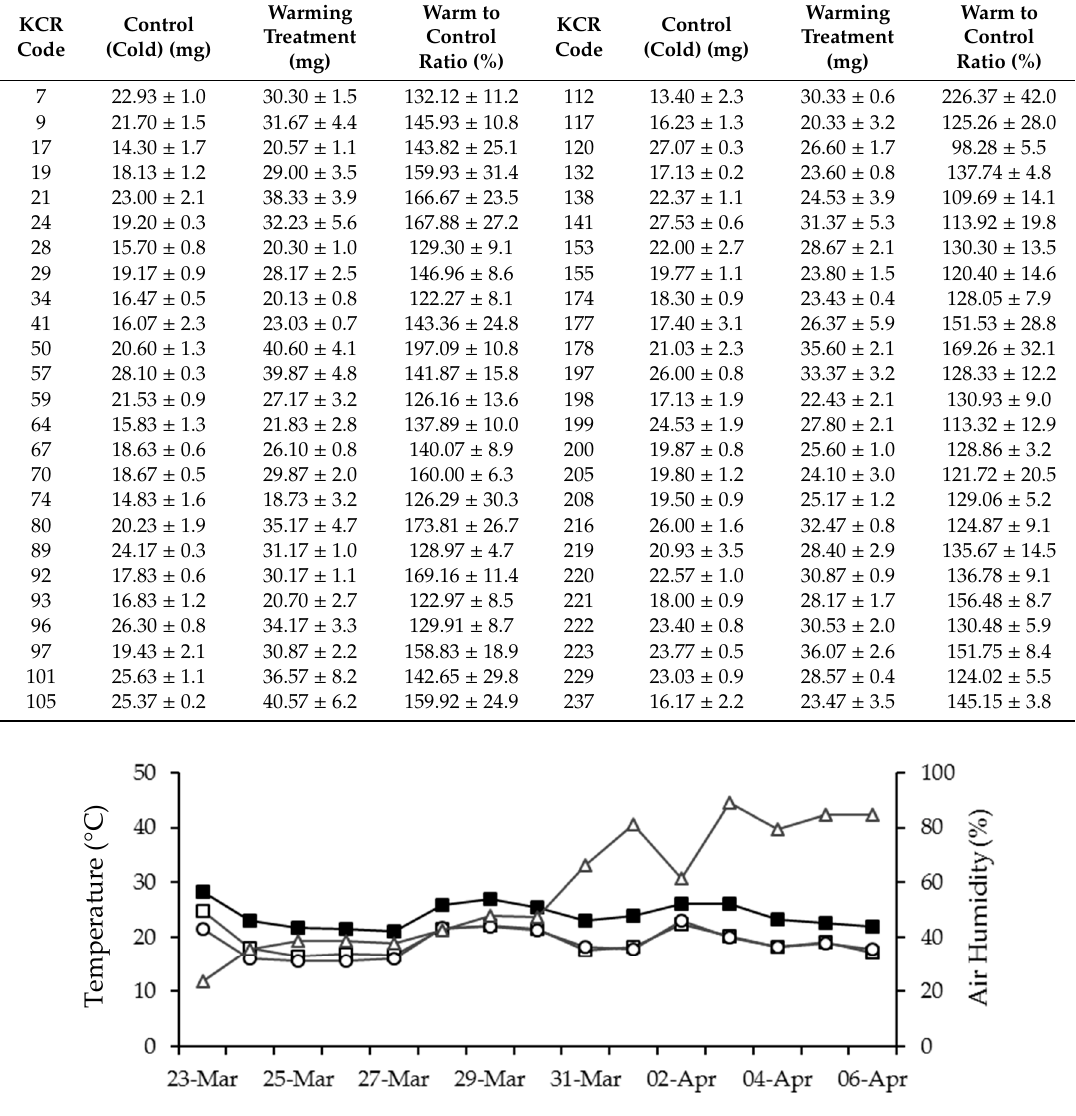
Table 6. Shoot dry weight of varieties under the control (cold) condition and warming treatment. KCR Code